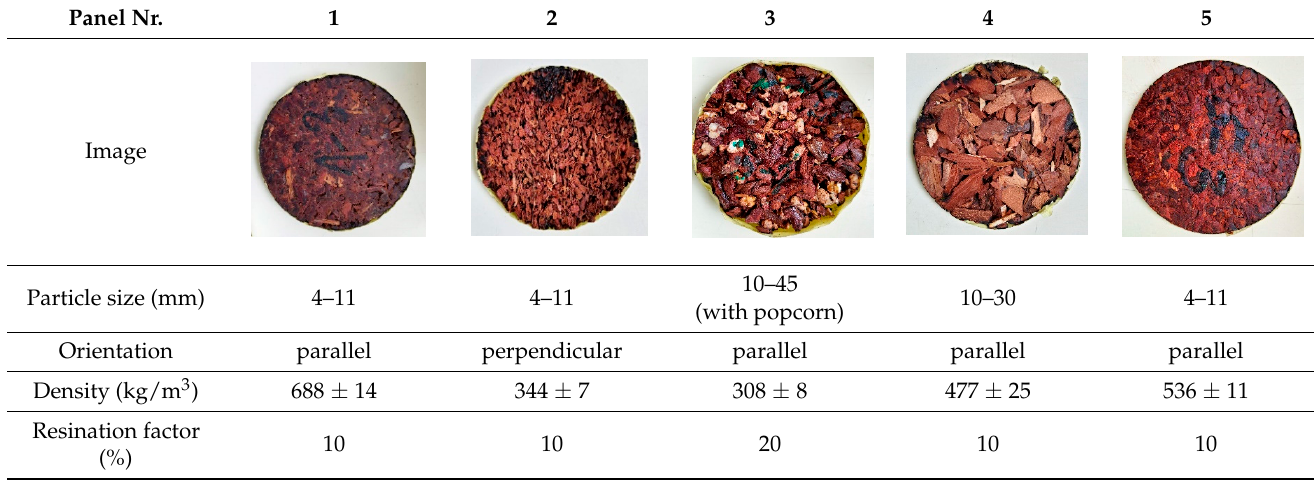
Table 2. Overview of parameters of tested specimens made of bark-based boards. Panel Nr.